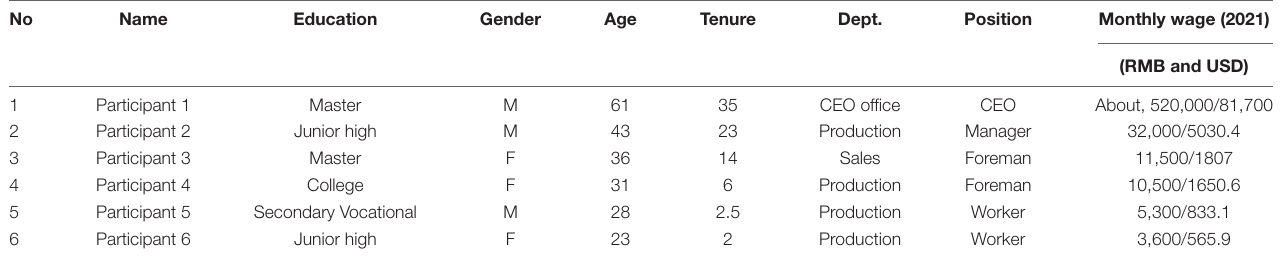
TABLE 1 | Demographic information of